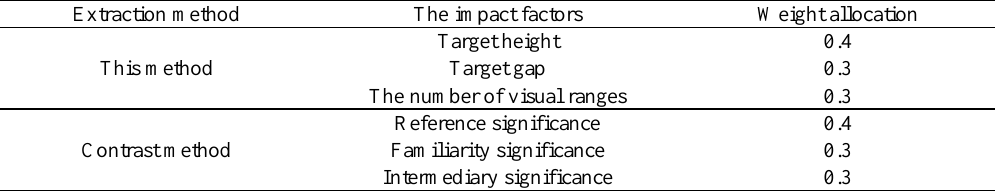
Table 1. Two methods of impact factor and weight allocation